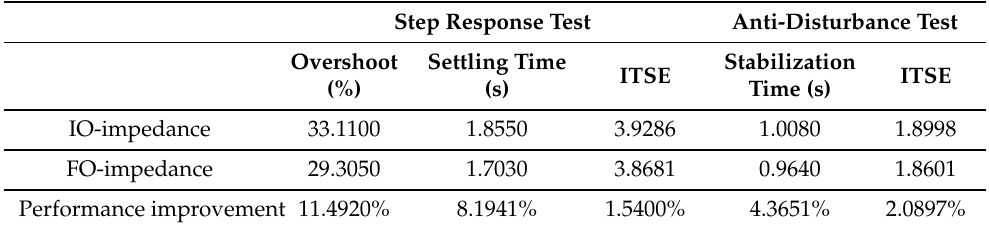
Table 5. Comparison of experimental performance between FO/IO-impedance